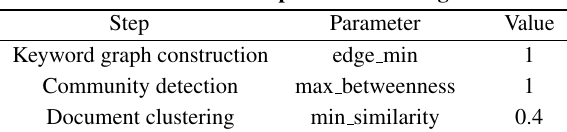
Table 1 Initial parameter